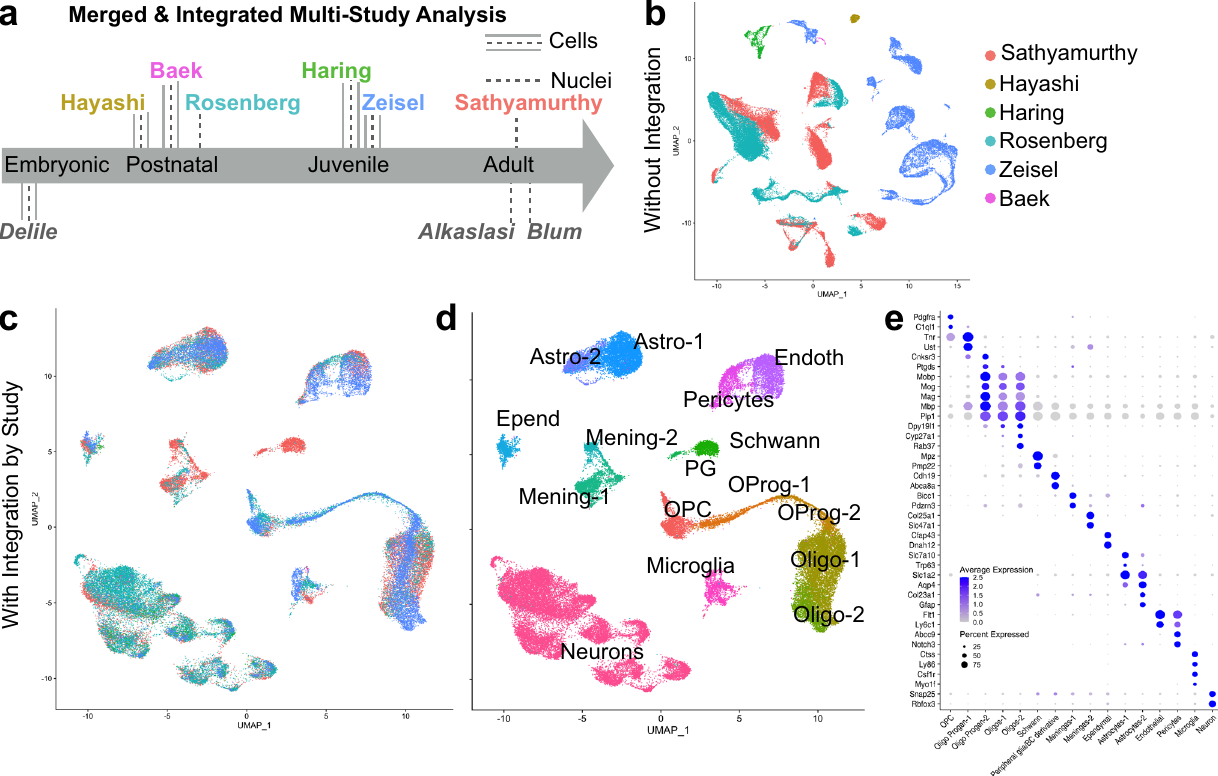
Fig. 1 Integration of six independent studies on single cell spinal cord data reveals the major cell types of the spinal cord. a Summary of the datasets used in this study, including the studies that used single-cell/nucleus RNA sequencing to analyze postnatal mouse spinal cord cell types (colored names above the gray bar) and additional studies that were used for focused aspects of the analysis below the gray bar. The age and technique (cell or nuclei isolation) is represented for each study. b UMAP presentation of the 52,623 cells/nuclei in the fi nal dataset, without integration and colored by the study of origin (colors in the legend). c UMAP presentation of the same 52,623 cells/nuclei in the fi nal dataset, integrated by study and colored by the study of origin (same colors as in ( b )). d UMAP presentation of the cells/nuclei in the merged dataset, integrated by study and colored by cell type. e Dot plot of the expression of marker genes for the major coarse cell types. Average expression for each cluster is shown by color intensity and the percent of cells/ nuclei in each cluster that expressed each gene is shown by dot